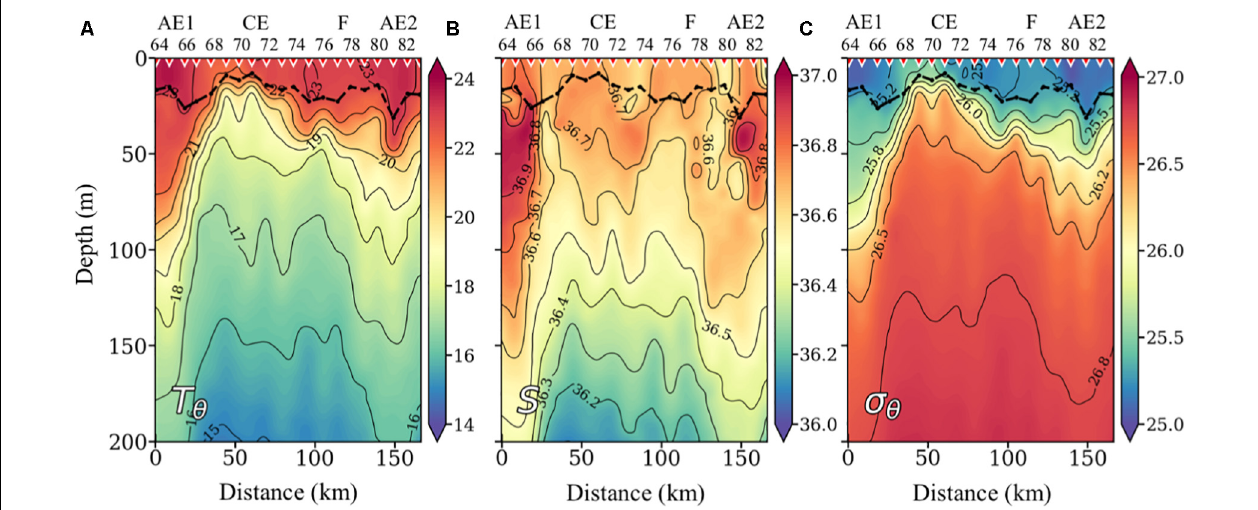
FIGURE 2 | Vertical sections of potential temperature (T θ ) in ◦ C (A) , potential density ( σ θ ) in kg · m − 3 (B) , and practical salinity (S) (C) . Inverted red triangles on the top axis indicate stations position. The locations of the anticyclonic eddies (AE), the cyclonic eddy (CE), and the filament (F) are also indicated on the top axis. The bold black line shows the depth of the mixed layer (MLD).